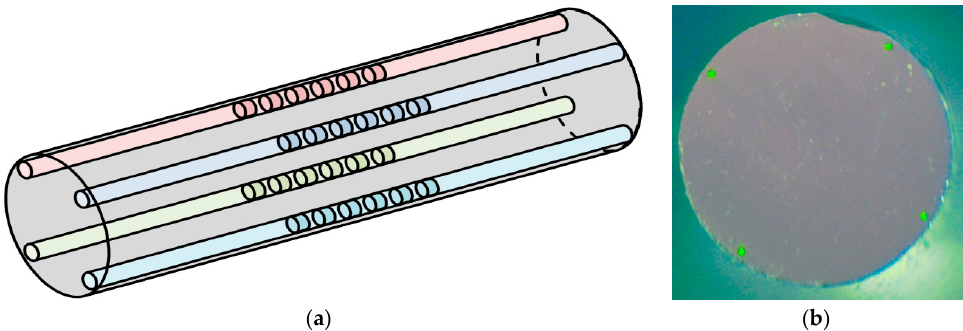
Figure 2. ( a ) Schematic design of a section of four-core silica rod with Bragg gratings; ( b ) Photo of the rod’s edge.